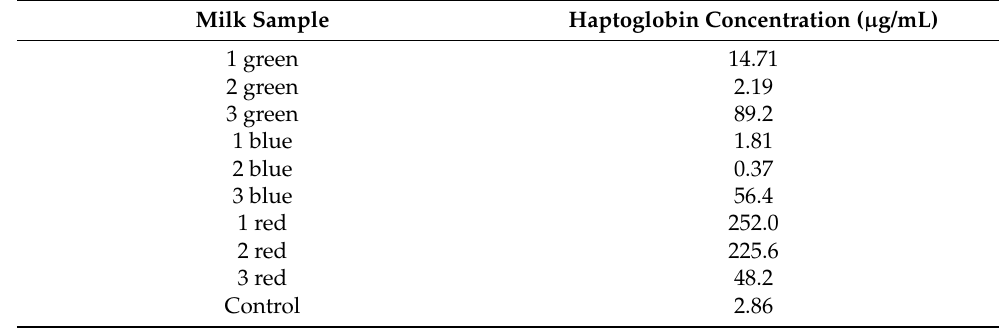
Table A1. Milk control samples owned by IMG Pharma whose haptoglobin concentration was determined by ELISA.